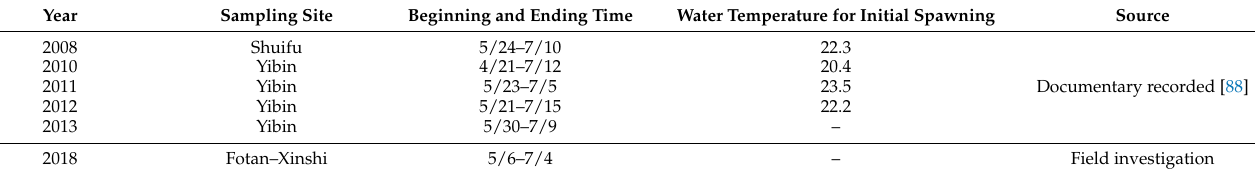
Table A1. Details of fields